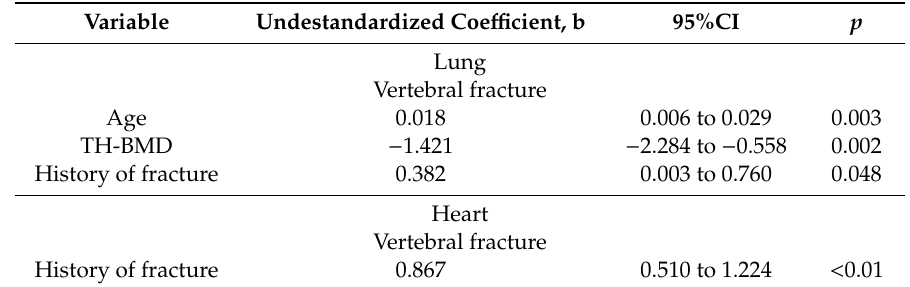
Table 2. Multiple linear regression analysis of predictors for the vertebral fracture in lung and heart transplantation